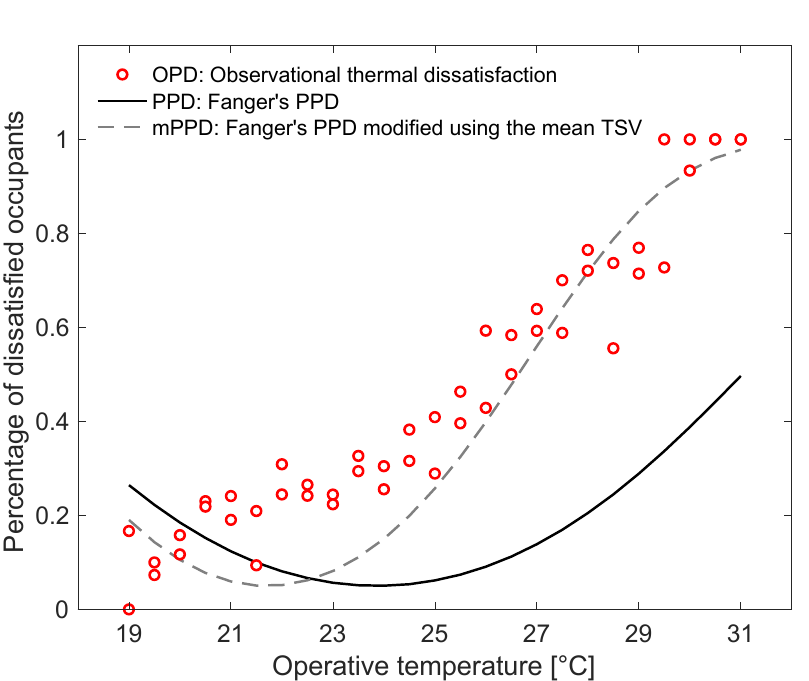
Figure 2. Relationship between the operative temperature and the percentage of dissatisfied occupants.